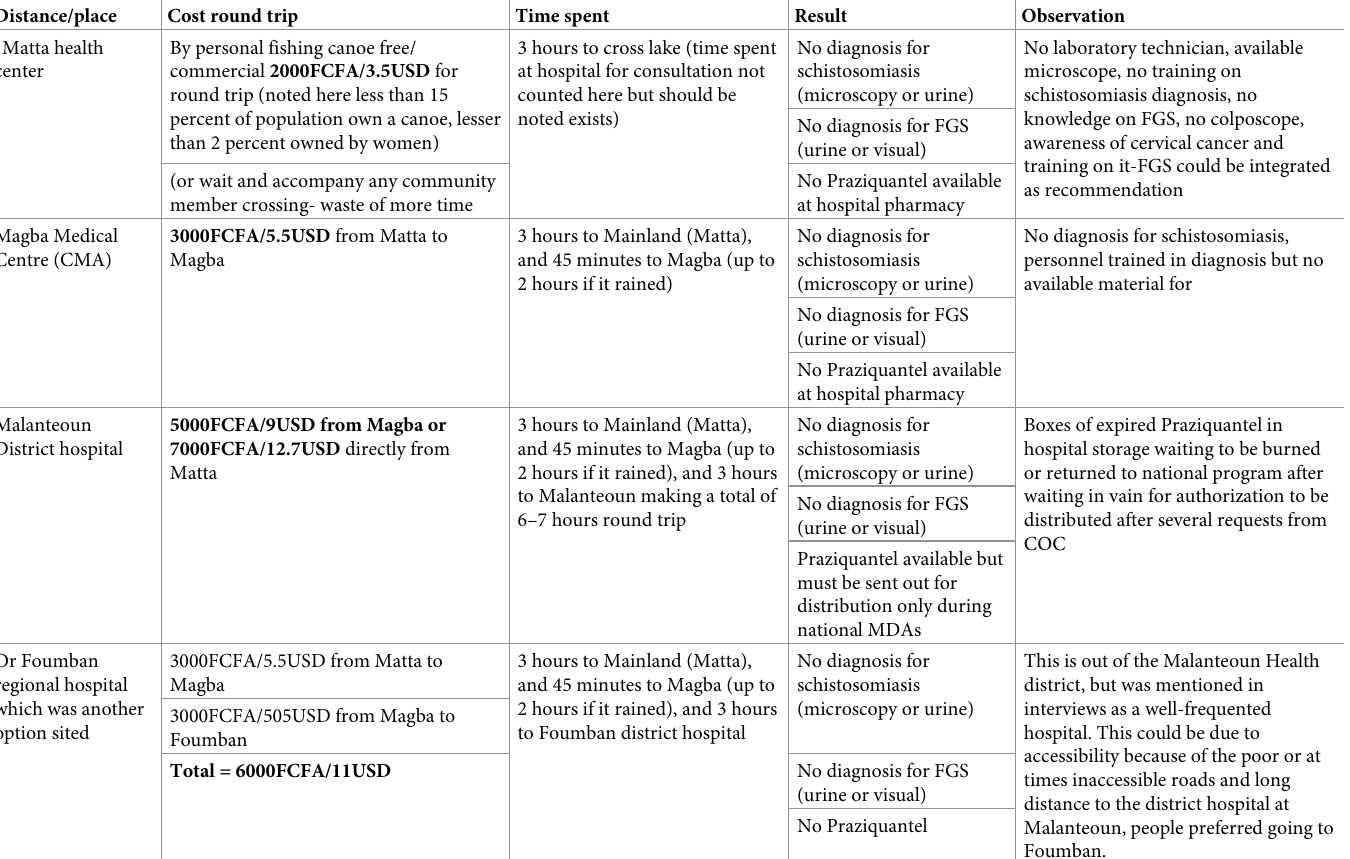
Table 6. Transportation cost table as per geographical location of Island.